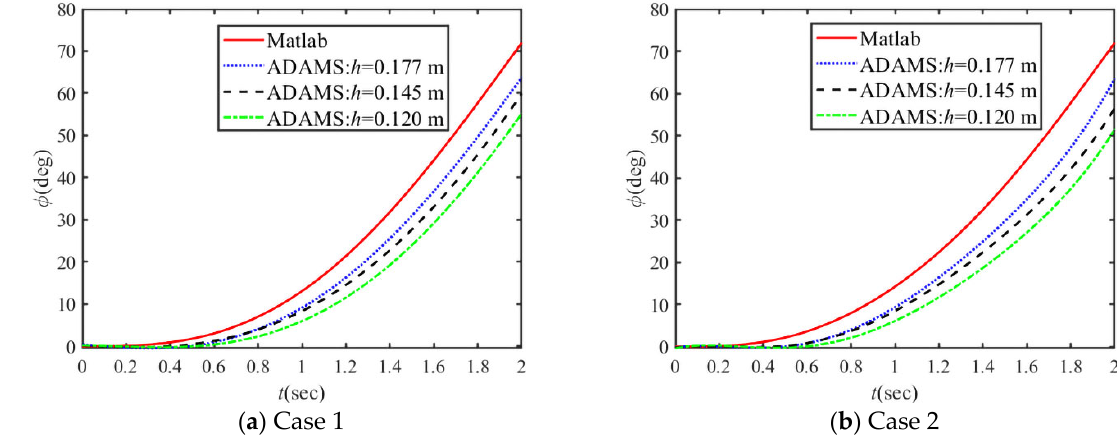
Figure 14. Theoretical and simulated results of rolling angular displacement.